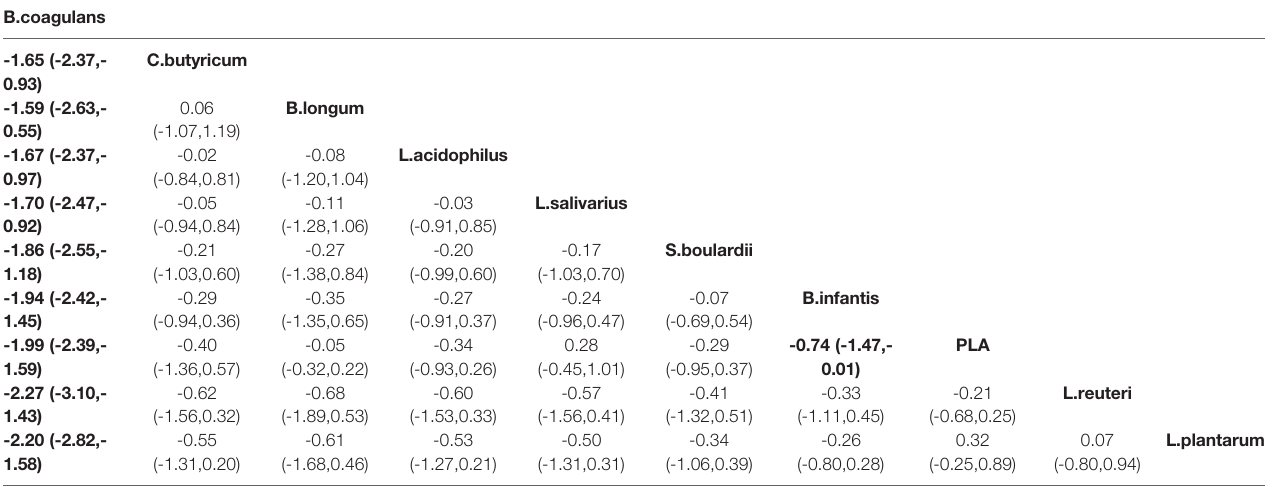
TABLE 3 | Standardized mean differences (SMDs) and 95% CI on global symptom scores.